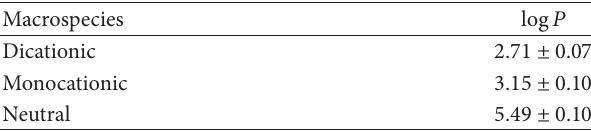
Table 1: Calculated log 𝑃 values of the different LAP